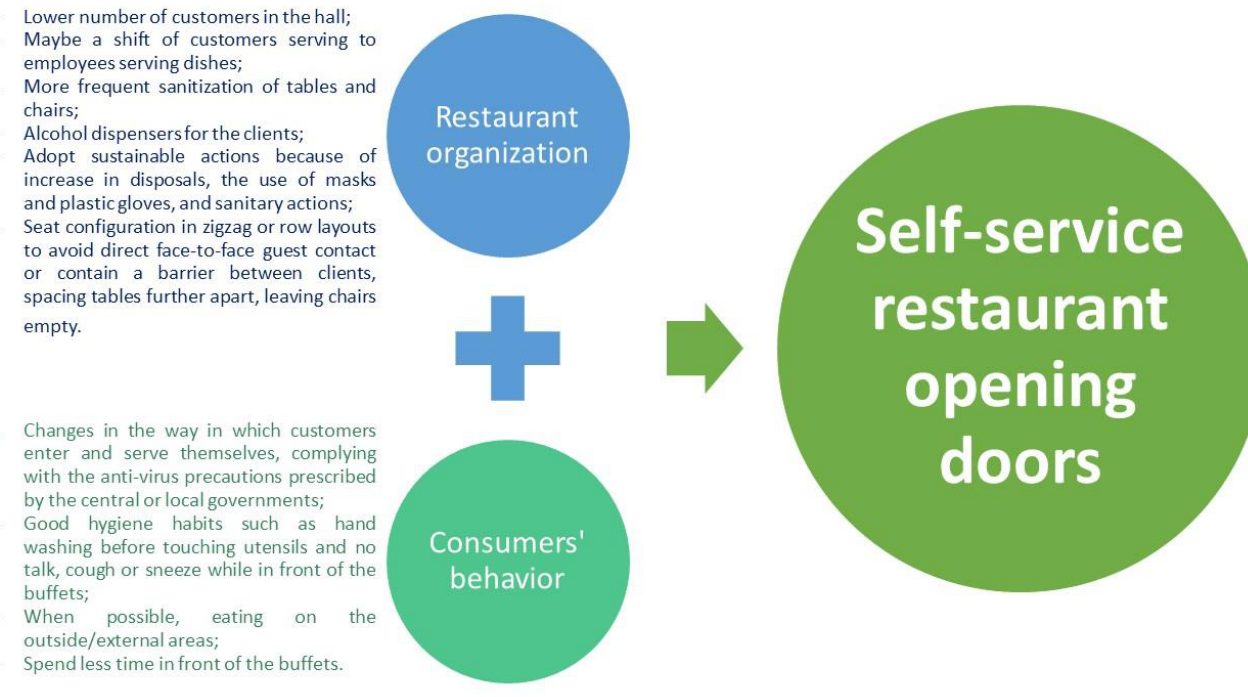
Figure 1. Proposed rules for self-service buffets during the COVID-19-pandemic.